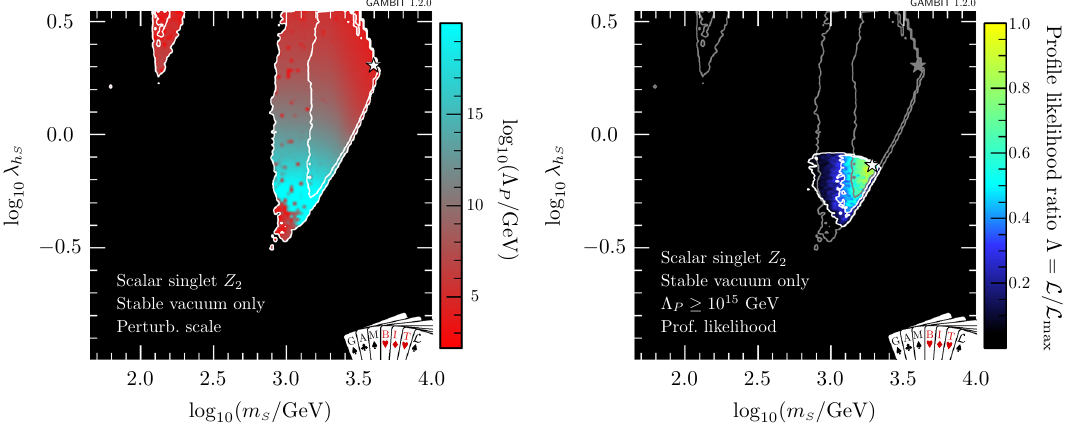
Fig. 6 Left: Scale of perturbativity violation for the Z 2 scalar sin- glet model with the requirement of a stable electroweak vacuum. Right: Profile likelihood when furthermore imposing the requirement Λ > 10 15 GeV. The 1 σ and 2 σ confidence regions are delineated by P